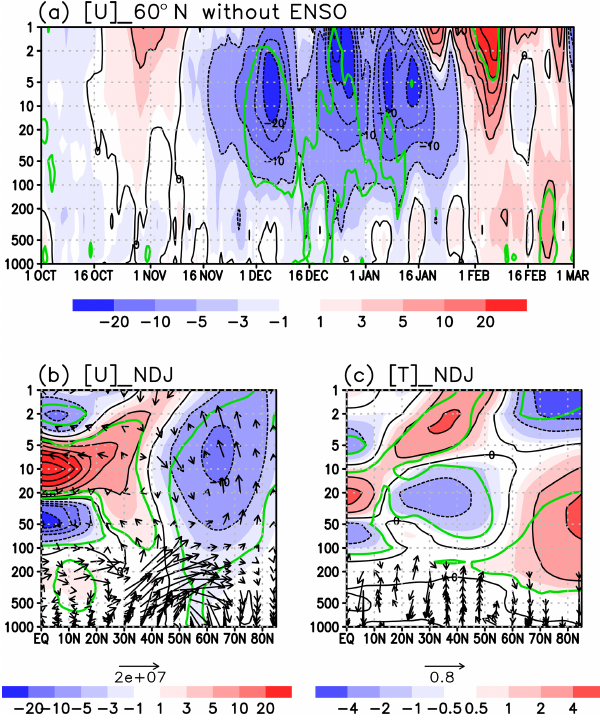
Figure 2. Same as Fig. 1 but without ENSO